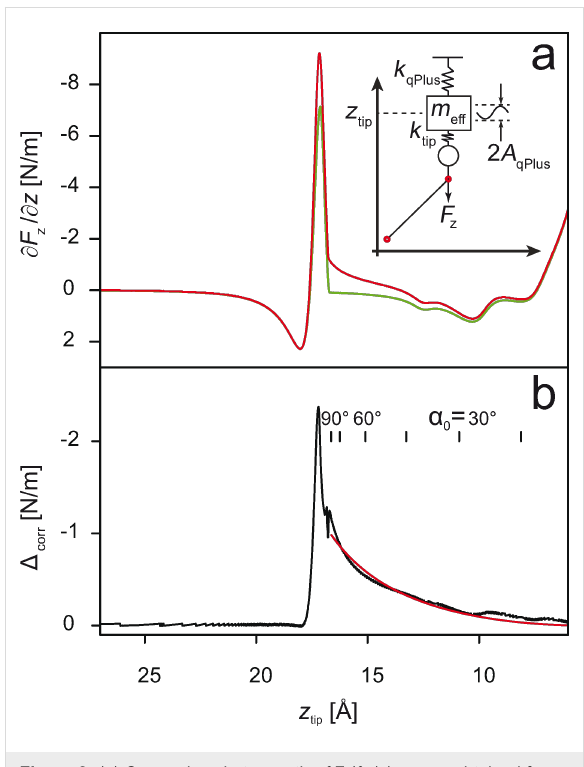
Figure 2: (a) Comparison between the ∂ F z / ∂ z ( z ) curves obtained from the initial ([11]) and the extended (this work) force-field model. The green curve is the same as the one shown in Figure 1b and was obtained with the model that accounts neither for oscillation of the qPlus sensor nor for the corrugation of the surface. The red curve is produced with the model taking both of the above effects into account (cf. text). The inset in the upper right corner clarifies the schematics of the single-molecule junction used in the extended simulation model. (b) Correction term Δ corr calculated as the difference between the two curves from panel (a). The red curve was obtained from the analytic expression (Equation 2) and fitted to the simulated Δ corr . Additional tick-marks show the correspondence between the α 0 and z tip scales (cf. text).